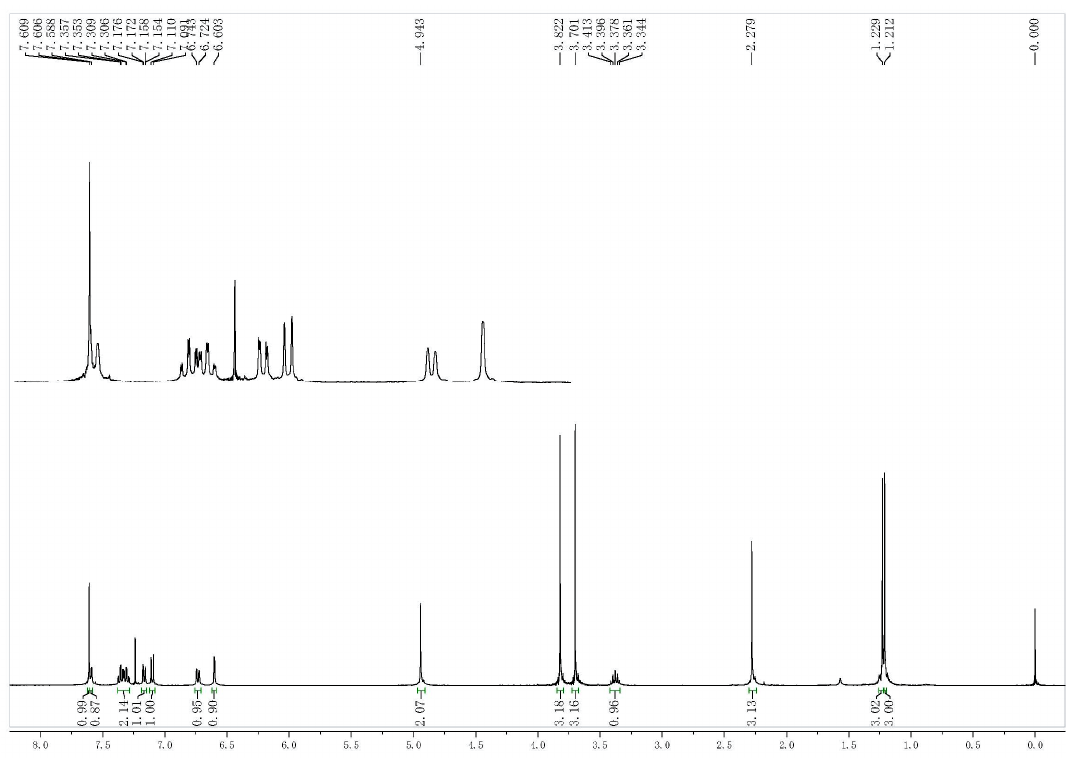
Figure 3. Representative 1 H-NMR spectrum of compound II-1 .